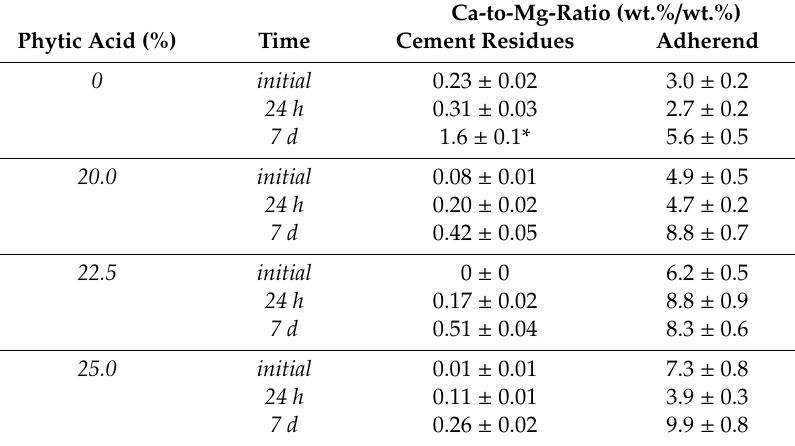
Figure 4. Examples of EDS element maps of cement adhesives made from farringtonite and either 2.0 M phosphoric acid (reference) or 25.0% phytic acid initially or after 7 d hardening in PBS at 37 °C on ground bovine bone samples. All cements were prepared in a powder-to-liquid ratio of 2.0 g/mL. The pictures show the Mg (green, cement residues) respectively Ca (blue, bone) map dispersion solely. Table 1. Ca-to-Mg-ratio on cement and adherend of the different bone adhesive samples. Concentrations of Ca and Mg were calculated based on corresponding EDS element maps. The ratios of one row derive each from the same (border) EDS element map (Figure 4).